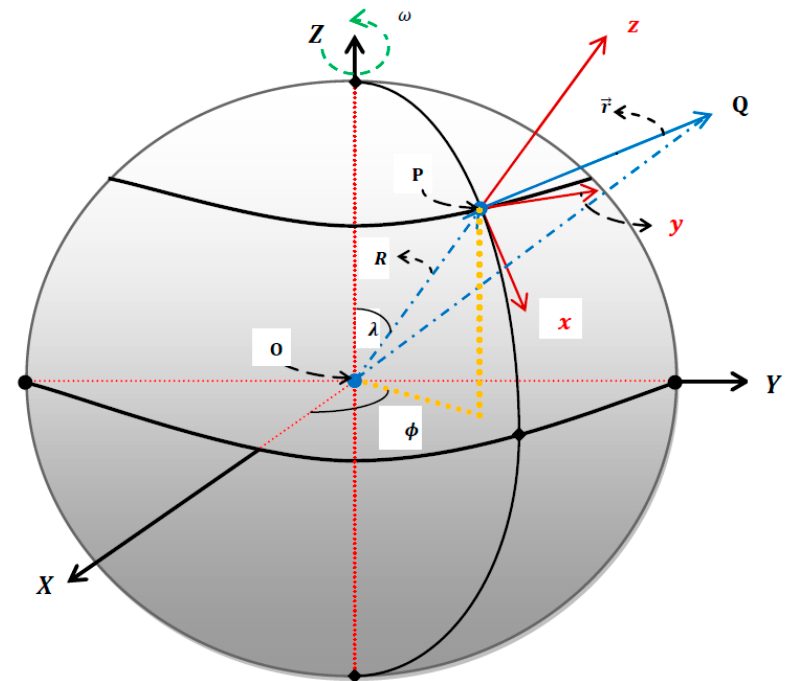
Figure 1. An inertial frame ( X,Y,Z ) attached to the centre of the Earth, and a point P on the surface, described by colatitude λ and longitude φ . The local Cartesian frame ( x,y,z ) at P. The x direction points south, the y direction points east, and the z direction points up. The position vector of a point Q relative to P is denoted r .